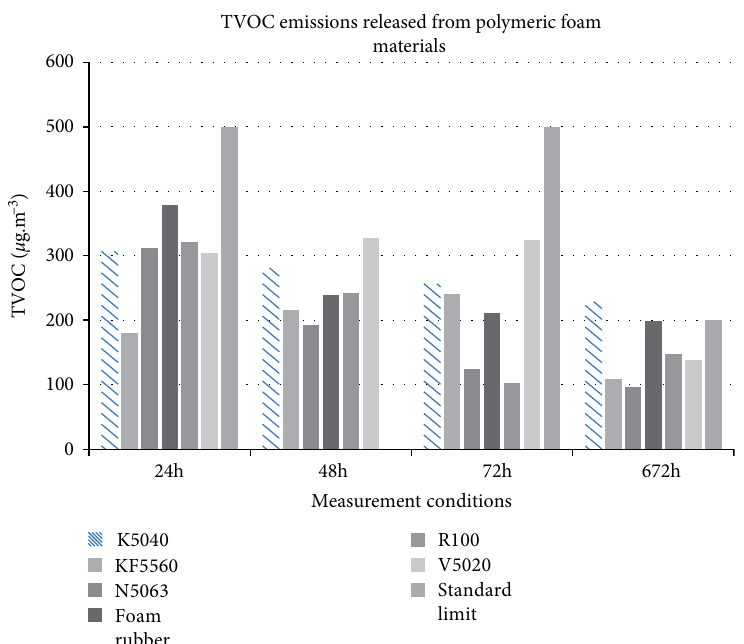
Figure 2: Measured TVOC concentrations for different foams with respect to time. (standard limits as per [21, 22], limits for 48 h not